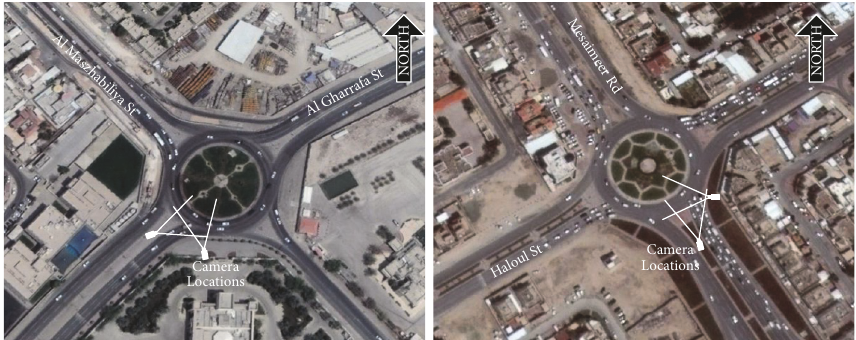
Figure 5: Aerial photo for roundabouts and camera